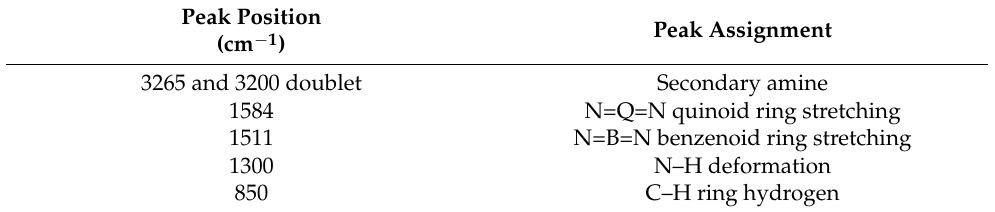
Table 2. Summary of FTIR absorption peaks of